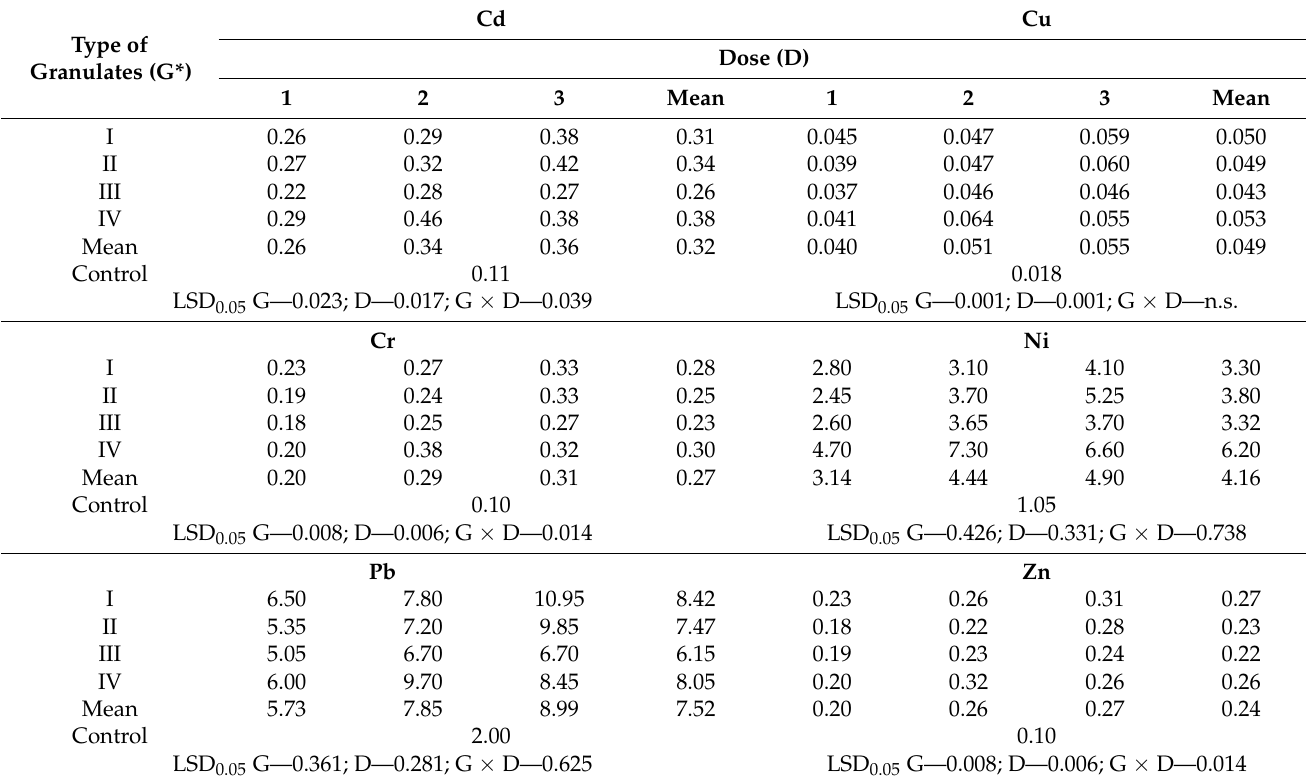
Table 7. Uptake of Cd, Cu, Cr, Ni, Pb and Zn in rape seeds (in mg · kg − 1 DM) to pot under the effect of sludge-ash